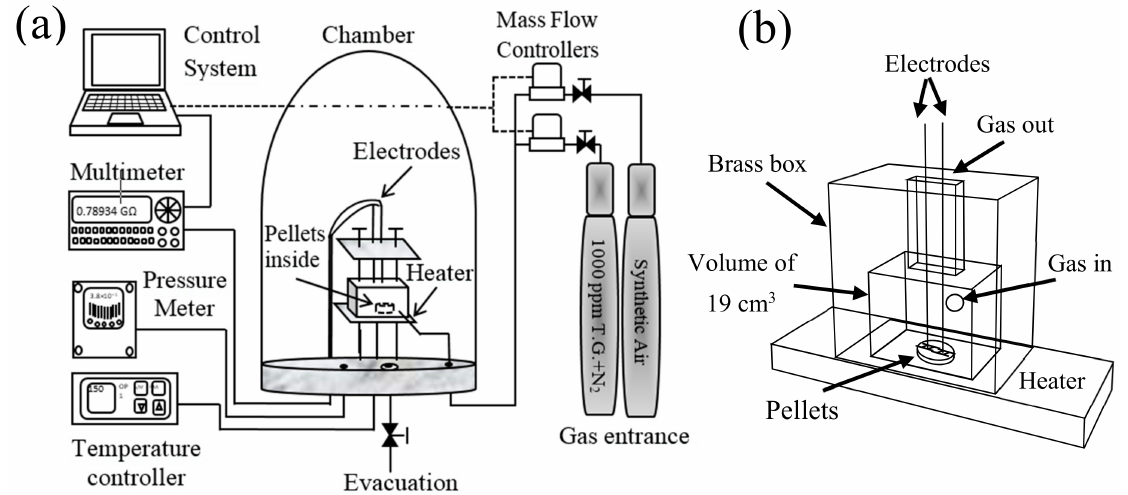
Figure 1. ( a ) Schematic of the system used to perform dynamic and static tests in direct current (DC) on pellets of the oxide at different concentrations and operating temperatures, and ( b ) Box used for the input and output of our propane